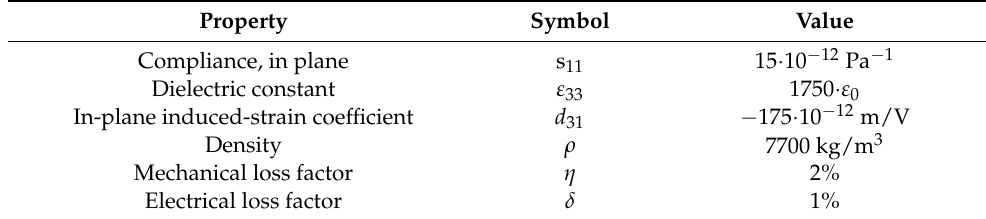
Figure 3. Normalized impedance values as function of the loading ZS / ZT ( KS / KT ) with all three models at 10 kHz.